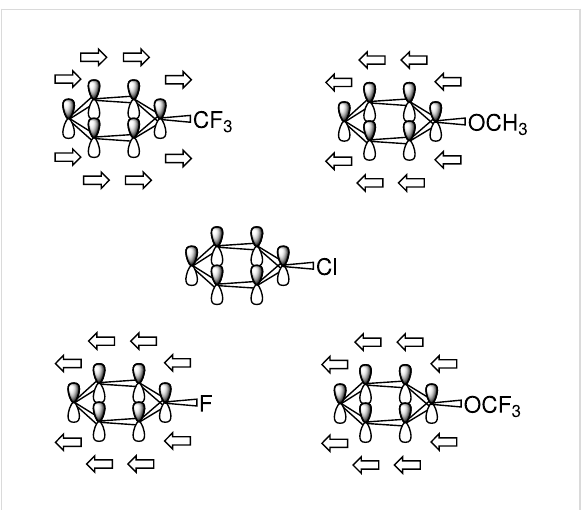
Figure 5: Direction of π-polarization depending on the substituent as described by Schlosser et al. [57].